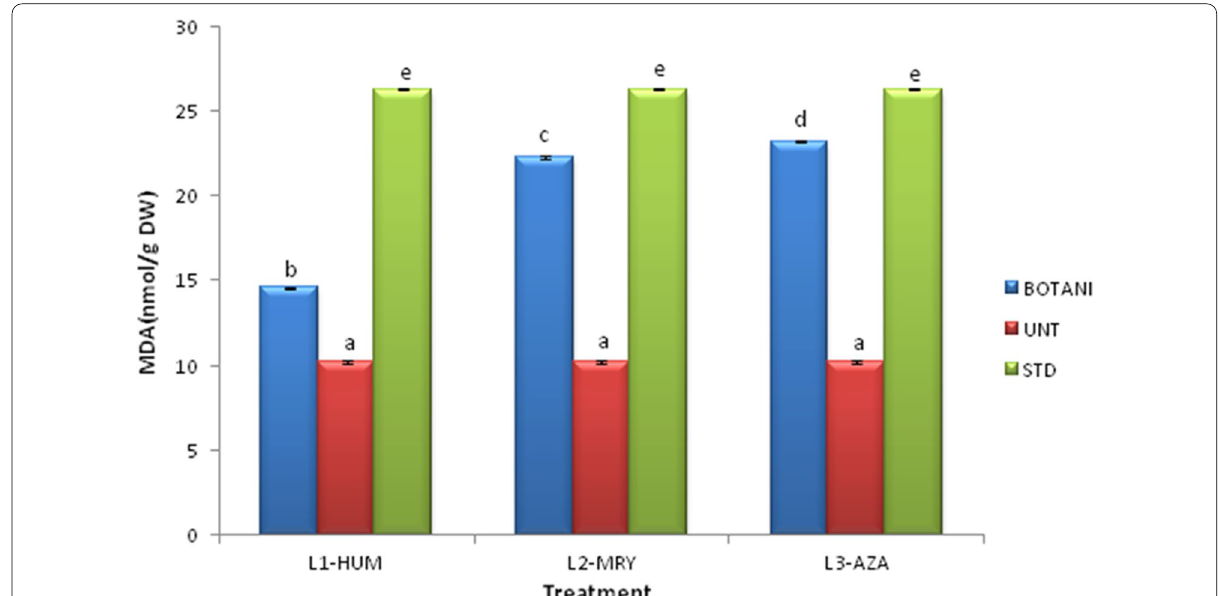
Fig. 2 Levels of malondialdehyde in SAMPEA 12 seed treated with botanical insecticides. Keys: BOTANI (Untreated seed), L5-STD